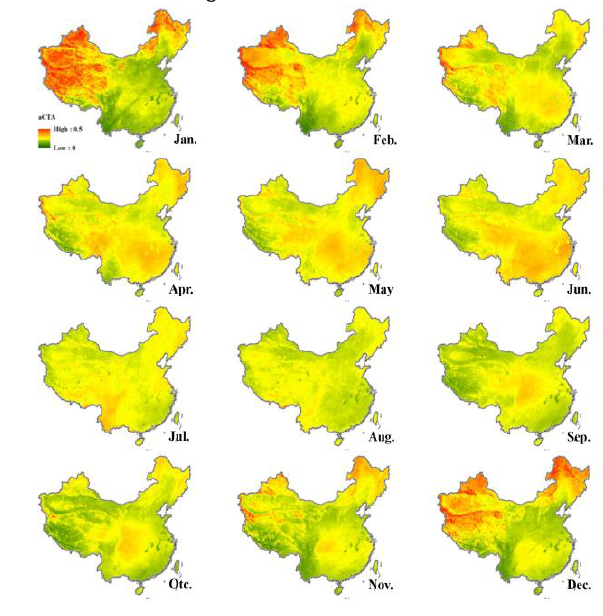
Figure 4. The spatial distribution of cloud total amount in China in different months